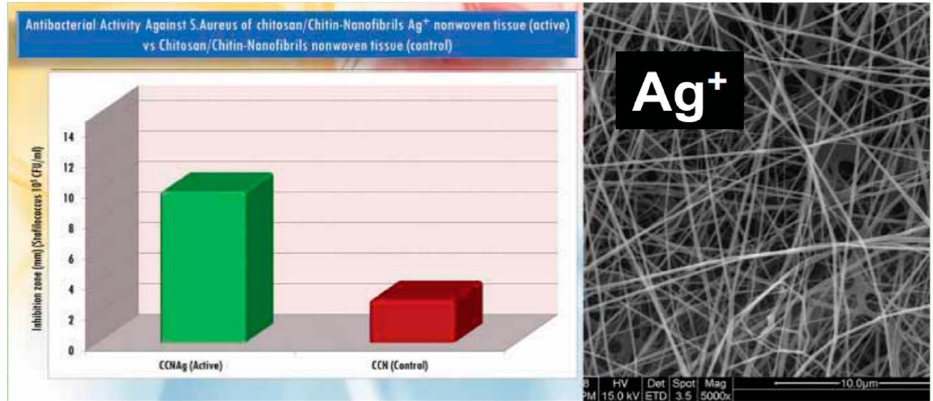
Figure 5. Antimicrobial activity of non-woven tissue made by polysaccharides and Chitin nanofibrils bound to nanosized Ag+ [68].